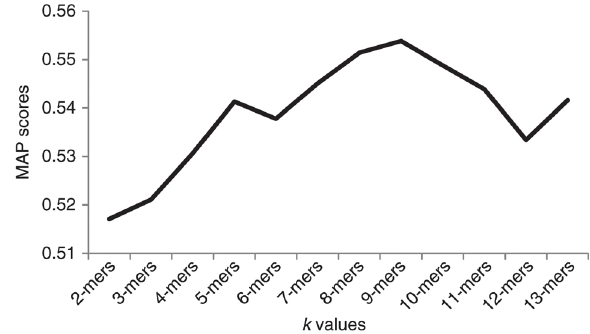
Figure 5: MAP scores of LDA fingerprint extraction method for different k values.